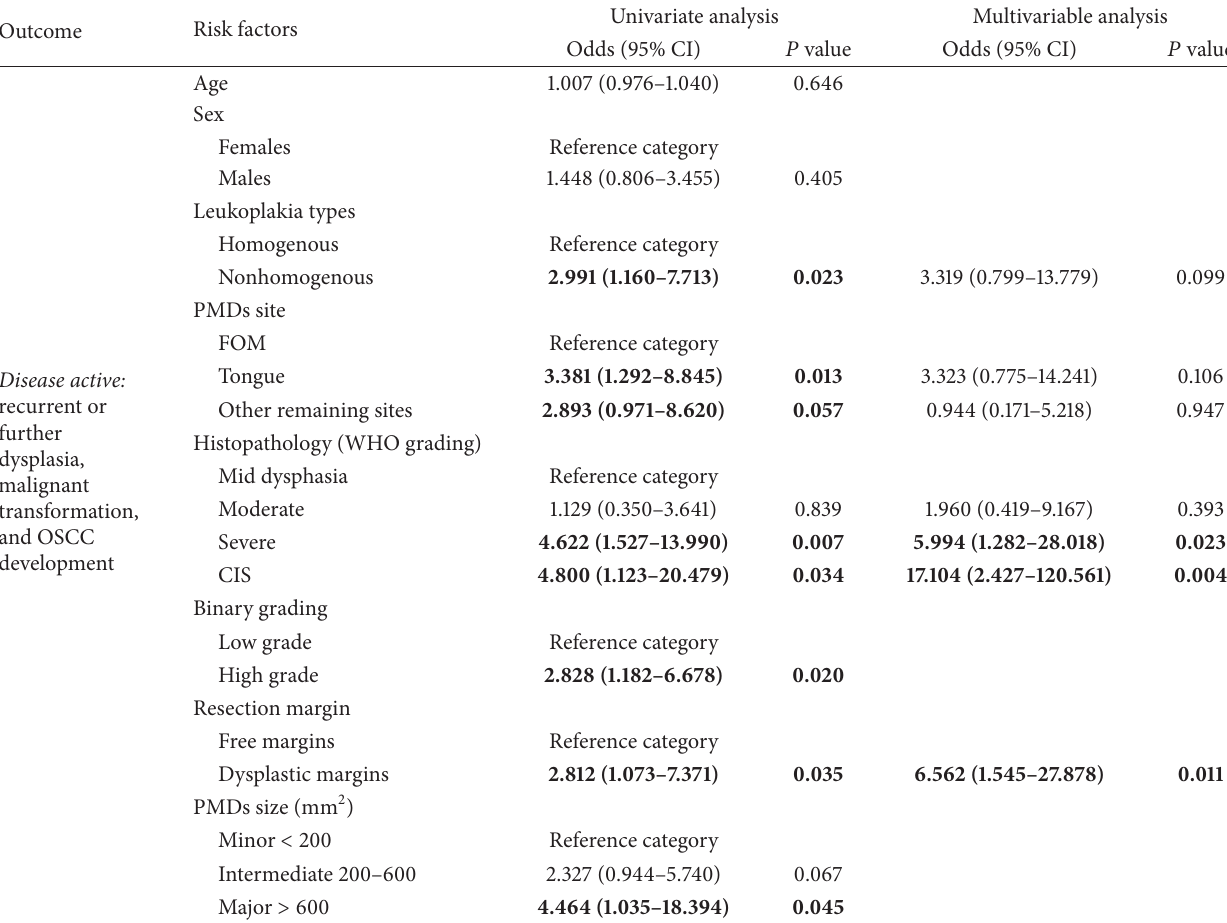
Table 3: Logistic regression models for “disease active”